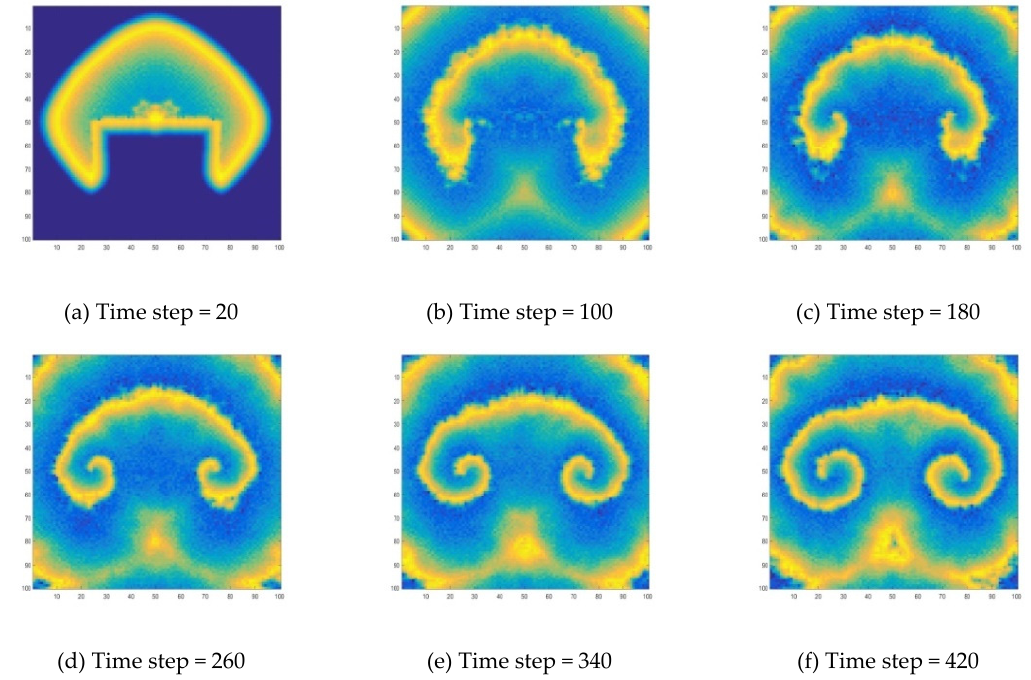
Figure 10. Simulate the development of spiral wave for B-Z reaction by PDE model.